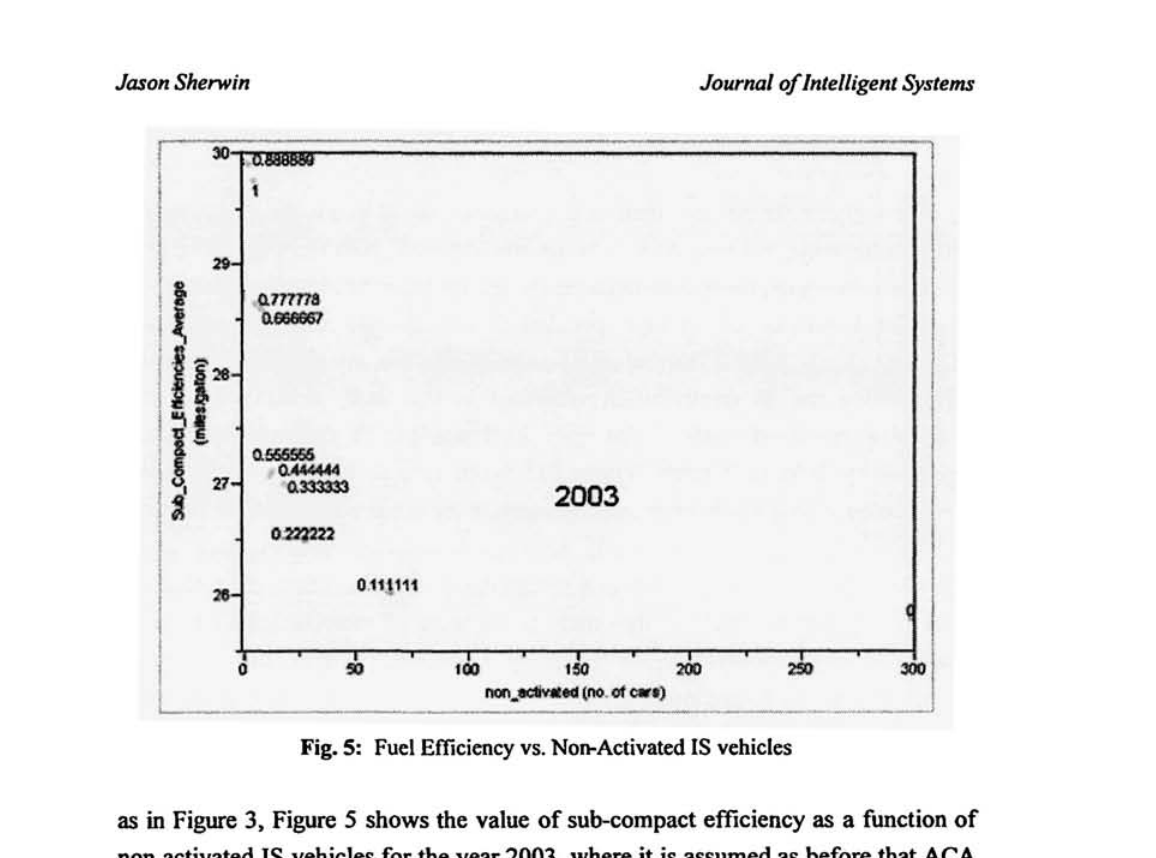
Fig. 5: Fuel Efficiency vs. Non-Activated IS